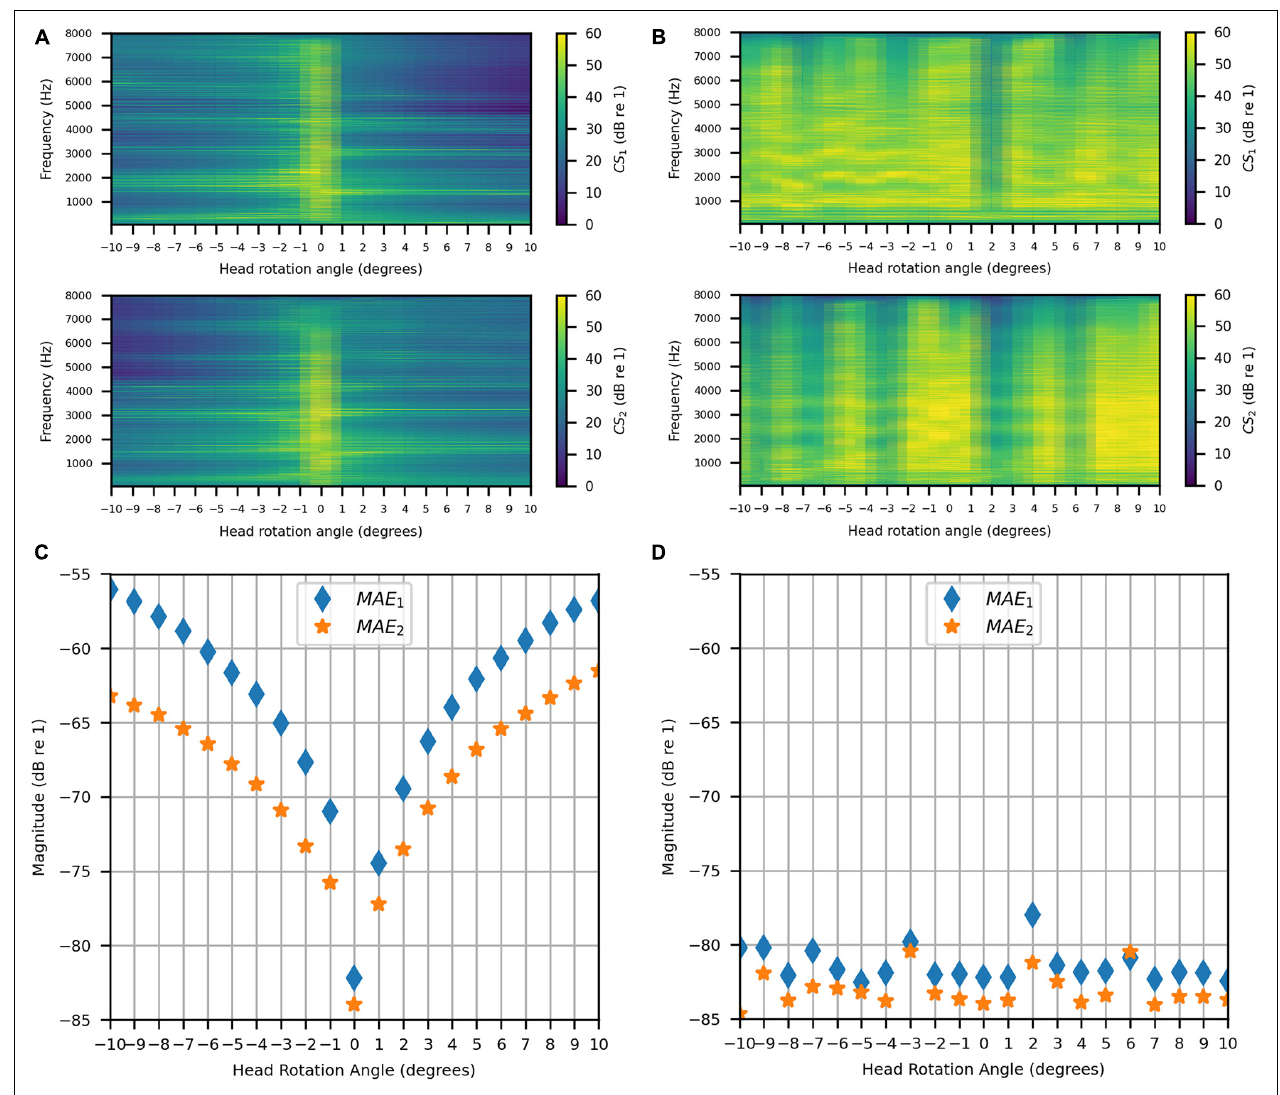
FIGURE 14 | Anechoic chamber: (A) Uncompensated channel separation as a function of frequency in Hz and head rotation angle; (B) Compensated channel separation as a function of frequency in Hz and head rotation angle; (C) Uncompensated mean absolute errors as functions of head rotation angle; (D) Compensated mean absolute errors as functions of head rotation